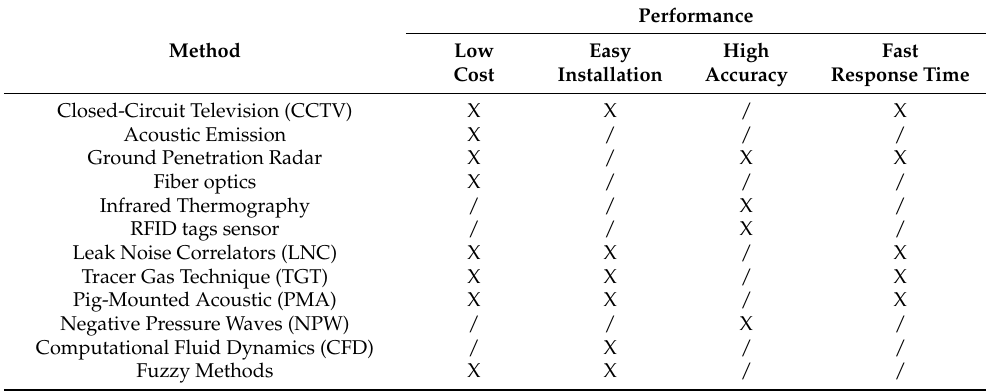
Table 3. Key performance summary of sensing technology in water leak detection method. “/” and “X” indicate the advantages and disadvantages of the method,